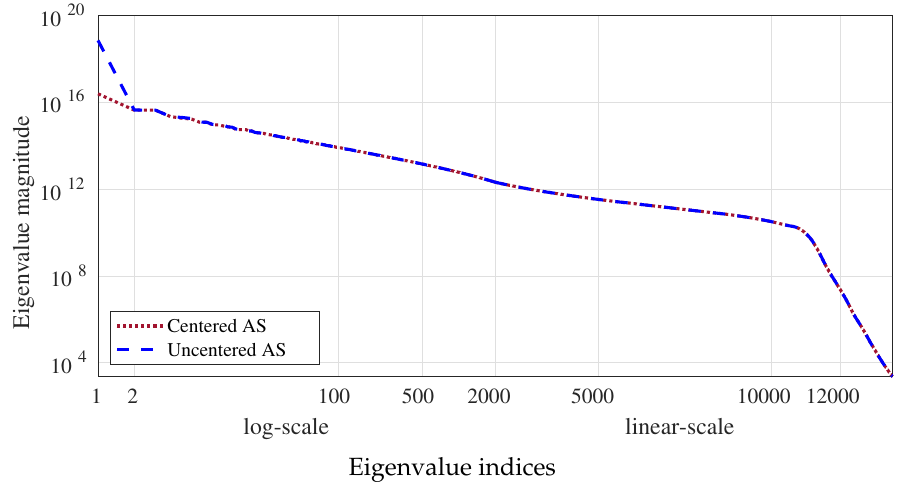
Figure 10. The spectrum of C (Uncentered Active Subspace) and ˜ C (Centered Active Subspace), noise level 1%.